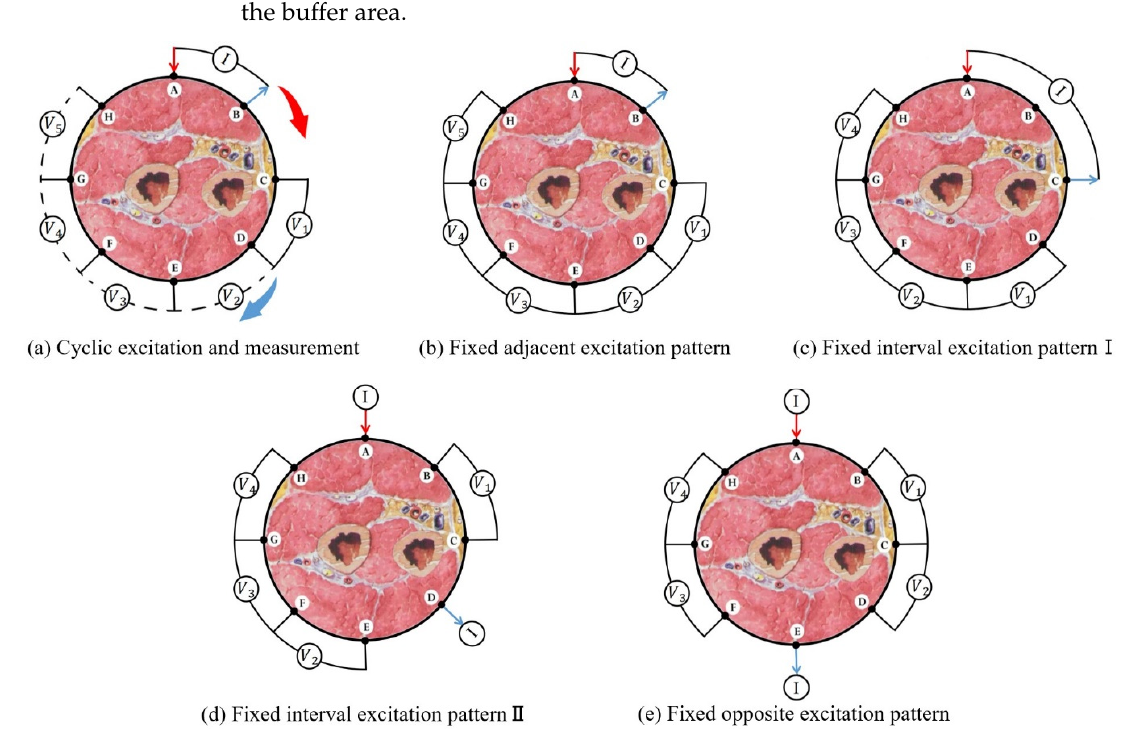
Figure 3. Different excitation drive patterns. The red and blue arrows represent the direction of movement of the excitation and measurement electrodes, respectively.